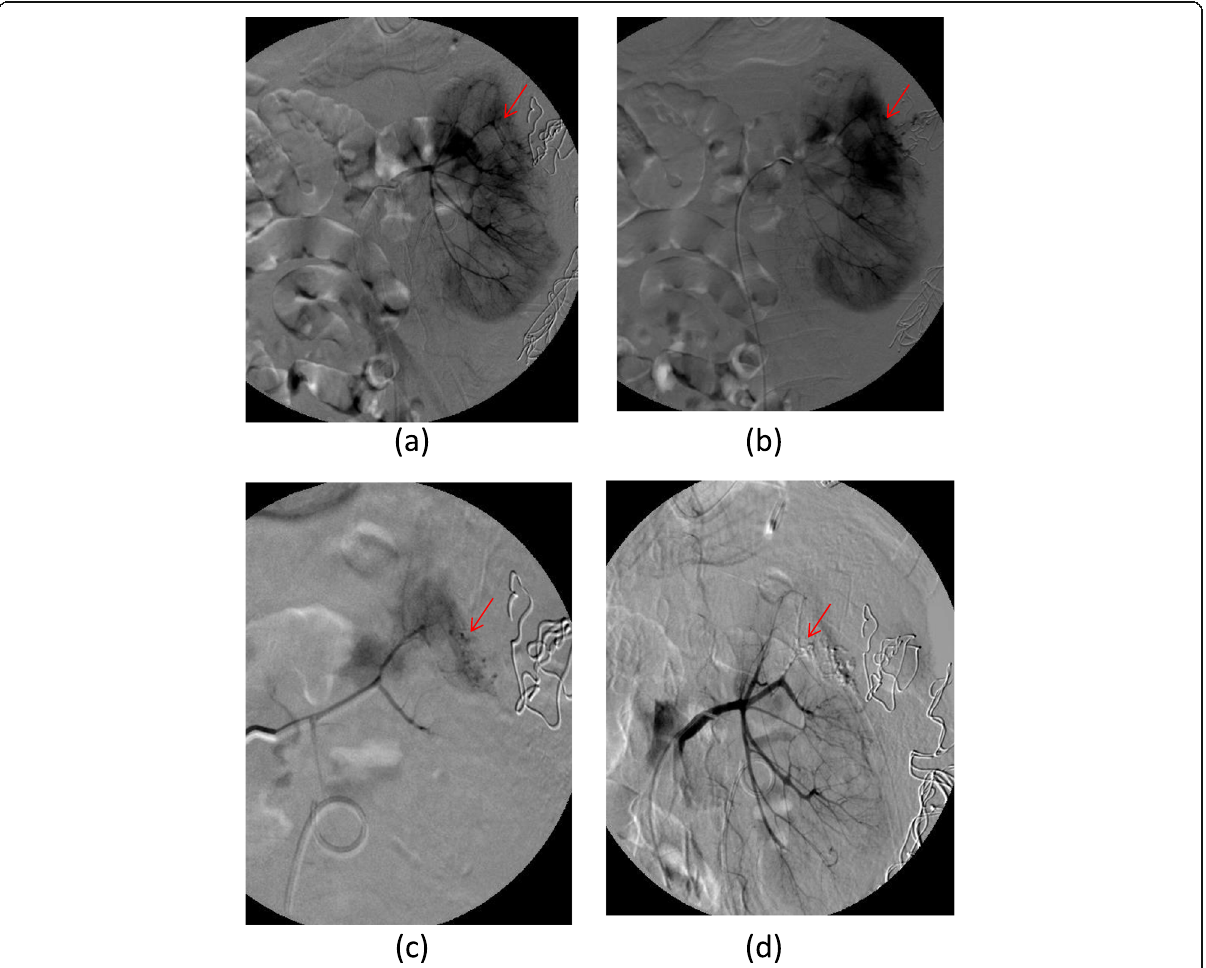
Fig. 5 A 14-year-old boy presented with persistent hematuria and perirenal hematoma after surgery for left renal trauma. Angiography with a Cobra catheter ( a , b ) and microcatheter ( c ) reveal contrast extravasation in the upper segmental branch of the left renal artery. The bleeding artery is successfully occluded by NBCA glue. Angiography with the Cobra catheter after embolization ( d ) showed that all bleeding arteries have been completely occluded. Normal renal arteries and the renal parenchyma are visible